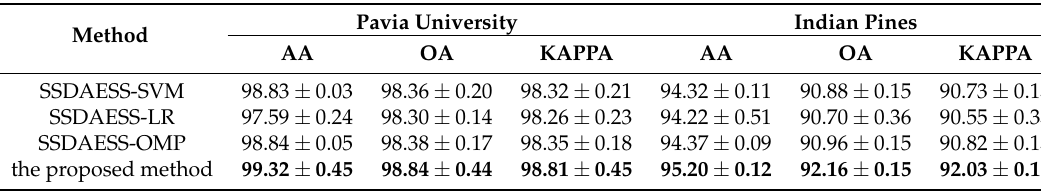
Table 7. Classification accuracy (%) of the proposed method and its three variants with different classifiers on two